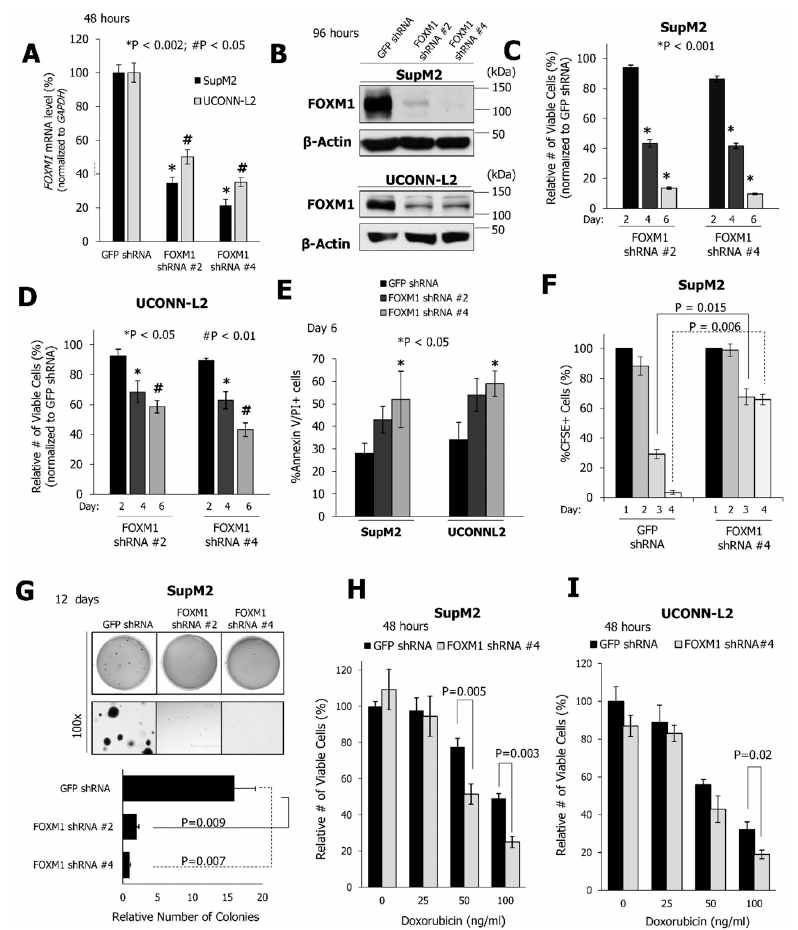
Figure 3. FOXM1 promotes cell growth and tumorigenicity of NPM-ALK + ALCL. ( A ) The FOXM1 transcript levels in SupM2 and UCONN-L2 cells 48 h following lentiviral transduction with one of two FOXM1-specific or a GFP-specific shRNA. ( B ) FOXM1 expression levels detected by a Western blot in SupM2 and UCONN-L2 cells 96 h following shRNA transduction with the indicated shRNA-containing vectors. β -actin was used as the loading control. ( C , D ) The relative number of viable cells (normalized to GFP shRNA) following trypan blue exclusion of SupM2 and UCONNL-2 cells 2, 4, and 6 days following transduction to express either GFP or FOXM1 shRNA. Results are normalized to the values of the GFP shRNA. ( E ) Annexin V / PI staining. ( F ) Proportion of cells with CFSE over the course of four days following GFP-specific or FOXM1-specific shRNA transduction. ( G ) Soft agar colony formation assay of NPM-ALK + ALCL cells transduced to express either GFP-specific or FOXM1-specific shRNA. ( H , I ) MTS assay was used to measure the number of viable SupM2 cells (H) or UCONN-L2 cells ( I ) following transduction with the indicated shRNA in the presence of increasing doses of doxorubicin as indicated. Data are representative of three biological replicates for SupM2 cells and two biological replicates for UCONN-L2